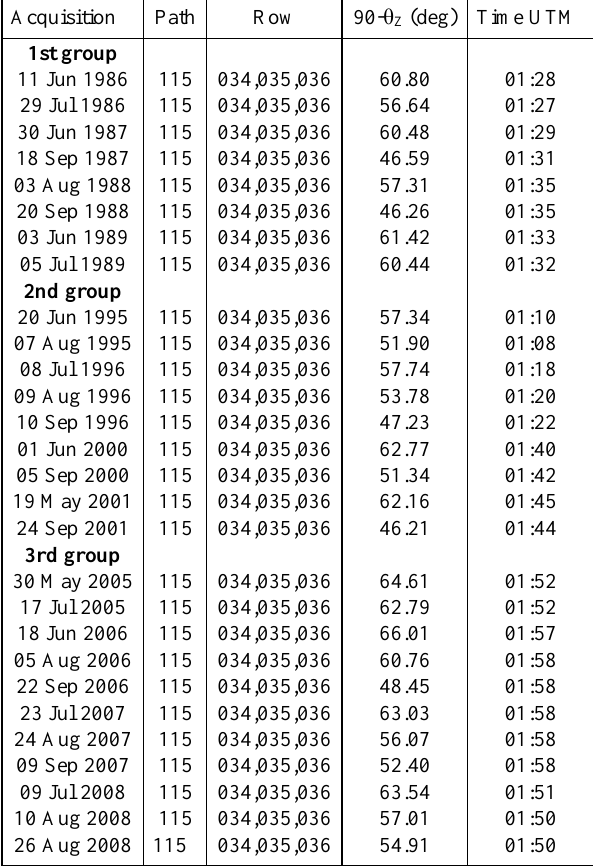
Table 1. Selected Landsat-5 TM